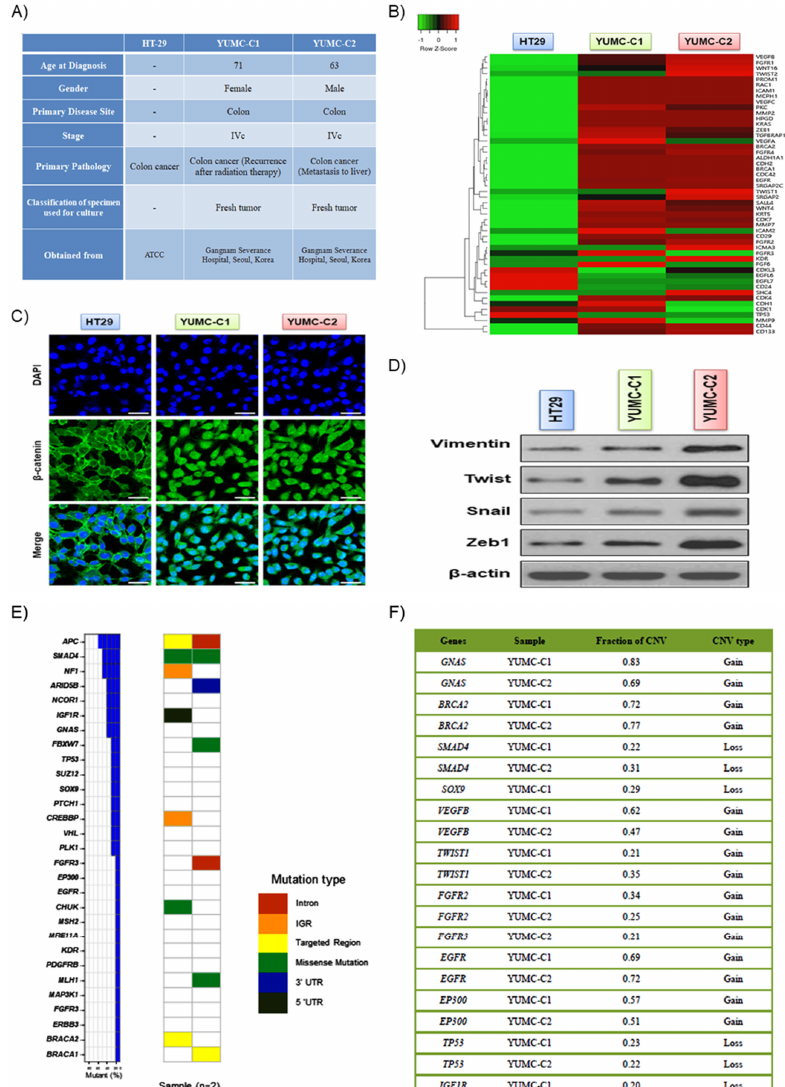
Figure 1. ( A ) Cell line characteristics, viability after drug treatment of all colon cancer cell lines examined. ( B ) Gene expression profiles of colon cancer cells. Gene expression analysis of HT-29 (American Type Culture Collection, ATCC) and YUMC-C1 and YUMC-C2 patient-derived colon cancer cells. ( C ) Immunofluorescence cytochemical staining about β -catenin in HT-29, YUMC-C1, and YUMC-C2 cells examined at 400 × magnification; scale bar, 20 µ m. ( D ) Immunoblot about markers of epithelial-mesenchymal transition (EMT). ( E ) Mutation rates of 29 driver genes in YUMC-C1 and YUMC-C2. The right panel represents the distribution of all mutations, which are colored pursuant to the mutation type. ( F ) Fraction of significant CNVs of driver genes in patient-derived colon cancer cells. All experiments were repeated at least 3